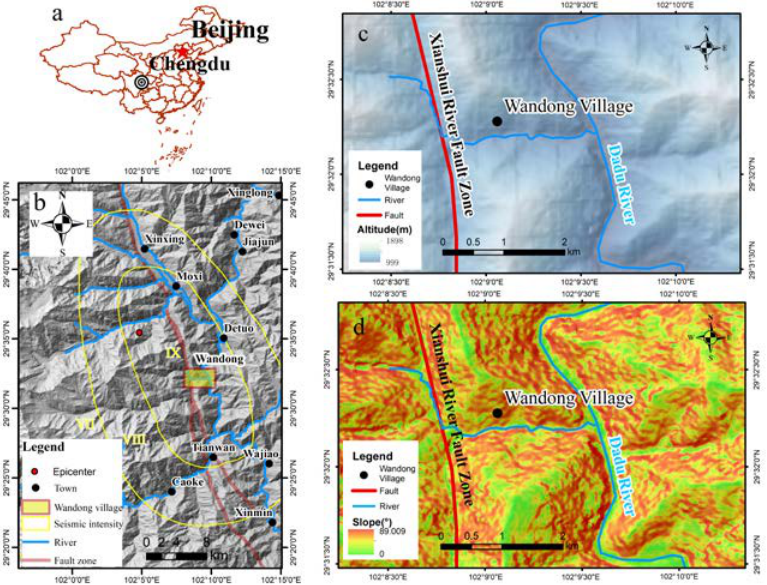
Figure 1. Schematic map of the disaster area ( a ). location of study area ( b ). hill shade map of study area ( c ) topographical map of study area. ( d ). slope map of study area.